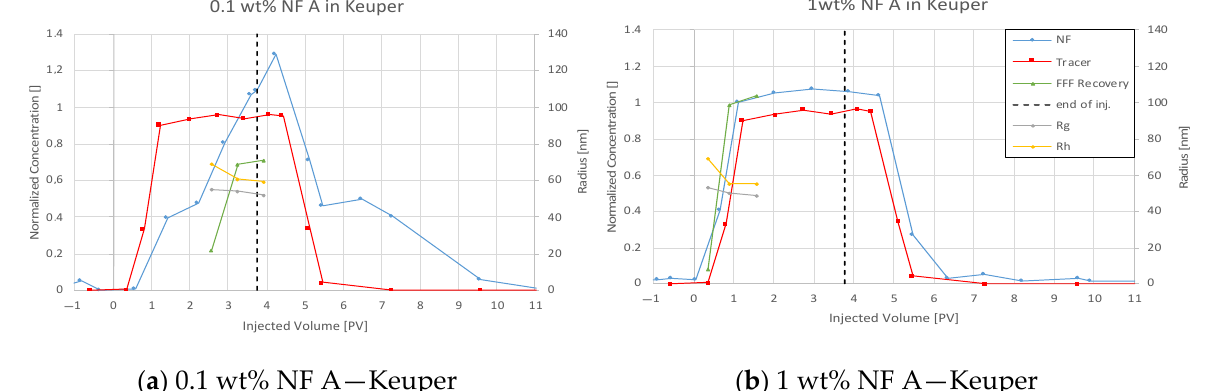
Figure 9. Effluent analysis for 0.1 wt% ( a ) and 1 wt% ( b ) NF A in TW in Keuper sandstone. A delayed breakthrough of nanomaterials can be seen in ( a ) peaking at a higher concentration than injected. An earlier nanoparticle breakthrough is seen in ( b ) compared to the tracer. Particle size measurements confirm UV–Vis concentration results and show larger particles arriving faster in the effluent. The comparison between tracer concentration history for both injection steps seen in Figure 10 shows a parallel breakthrough of tracer. However, the plateau is reached slower, and a delay in concentration reduction can be observed for the second injection step. Particle size measurements reveal that larger particles elute earlier compared to smaller ones for both injection steps.